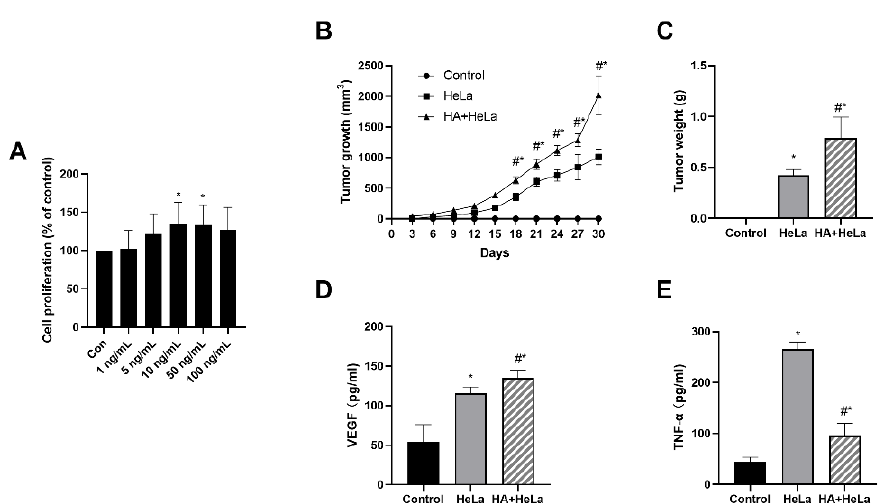
Figure 1. Histamine treatment induced cervical cancer growth in vivo and in vitro. HeLa cells were injected subcutaneously into the lower right side of female BALB / c nude mice. After 6 days, mice were randomly divided into three groups: control, HeLa (no histamine), HA + HeLa (1 mg / kg). Animals were intraperitoneally injected with histamine or PBS (same volume as histamine treatment) every 3 days. ( A ) HeLa cell proliferation after treatment with di ff erent concentrations of histamine (1, 5, 10, 50, 100 ng / mL). HeLa cells were incubated with histamine for 48 h. ( B ) Average tumor volume was measured every 3 days. ( C ) Tumor weights were measured at the end of treatment. ( D ) ELISA analysis for serum VEGF levels. ( E ) ELISA analysis for serum TNF- α levels. The serum used in ( D , E ) was obtained by the orbital sinus of mice. Histamine promoted cervical cancer growth according to the tumor growth and tumor weight. Data are presented as the mean ± SEM of at least three independent experiments. * p < 0.05 versus the control group, # p < 0.05 versus the HeLa group .